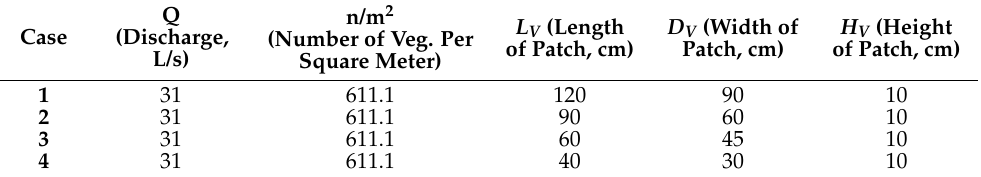
Table 2. Experimental parameters for the four cases discussed in this